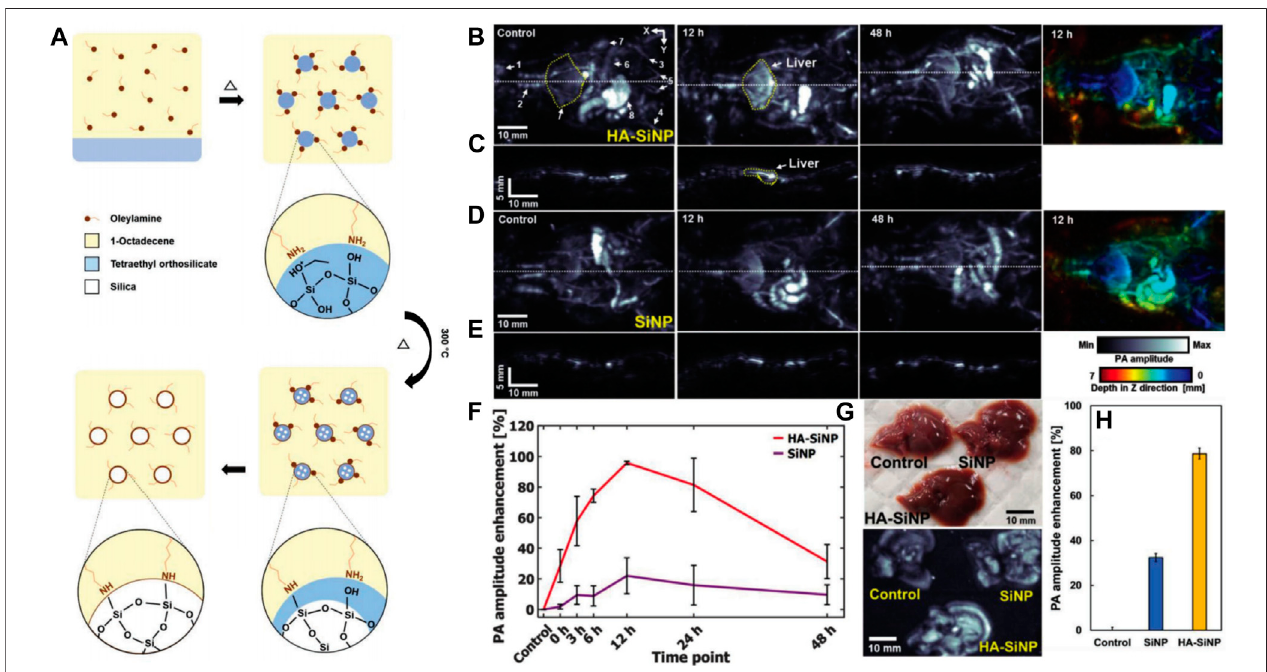
FIGURE4|(A) PreparationofSiNP. (B) Invivo PAMAPimagesandadepth-colorencodedPAimageofmousewholebodyafterHA – SiNPconjugateinjection. (C) PA cross-sectional images at the white dashed line in (B) . (D) In vivo PA MAP images and a depth-color encoded PA image after SiNP injection. (E) PA cross-sectional images at the white dashed line in (D) . (F) PA amplitude pro fi le in the liver region from before injection to after HA – SiNP conjugate and SiNP injection ( n (cid:2) 3). (G) Photograph and ex vivo liver PA MAP image 12 h after HA – SiNP conjugate and SiNP injection. (H) Ex vivo PA amplitude enhancement at HA – SiNP conjugate and SiNP injected liver ( n (cid:2) 3). Reprinted with permission from Lee et al. (2018). Copyright (2018) John Wiley and